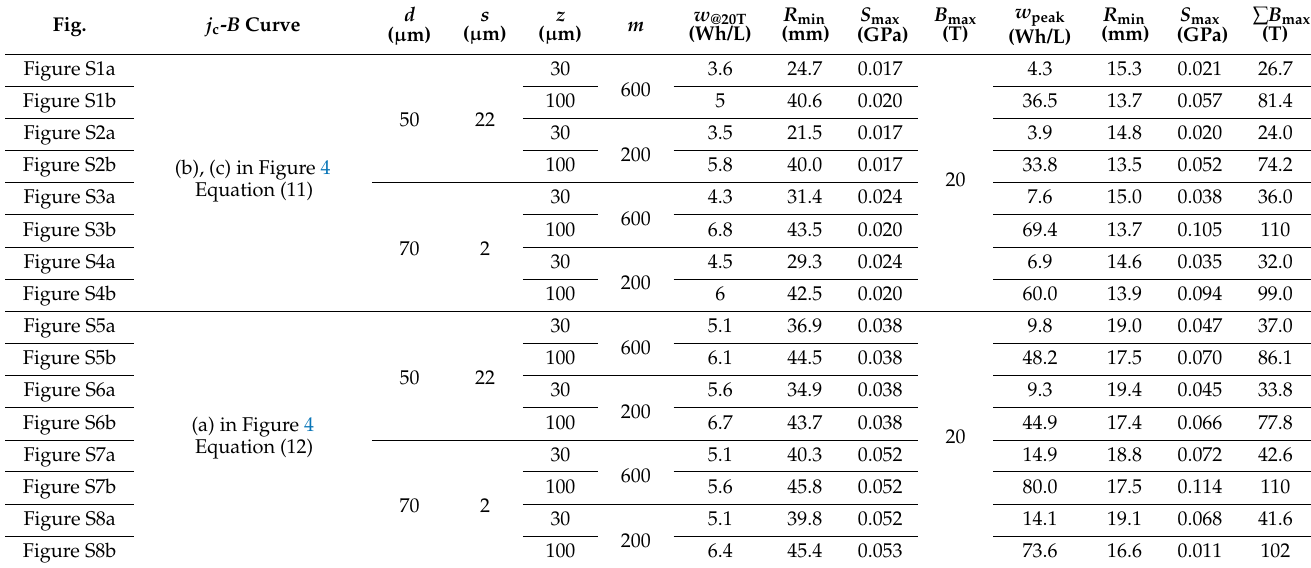
Table 1. Calculated values of w , R min , S max , and Σ B max for the different wafer coil design parameters, d, s, z , and the number of the stacked wafer coils, m , under the different Σ B max dependences of j c